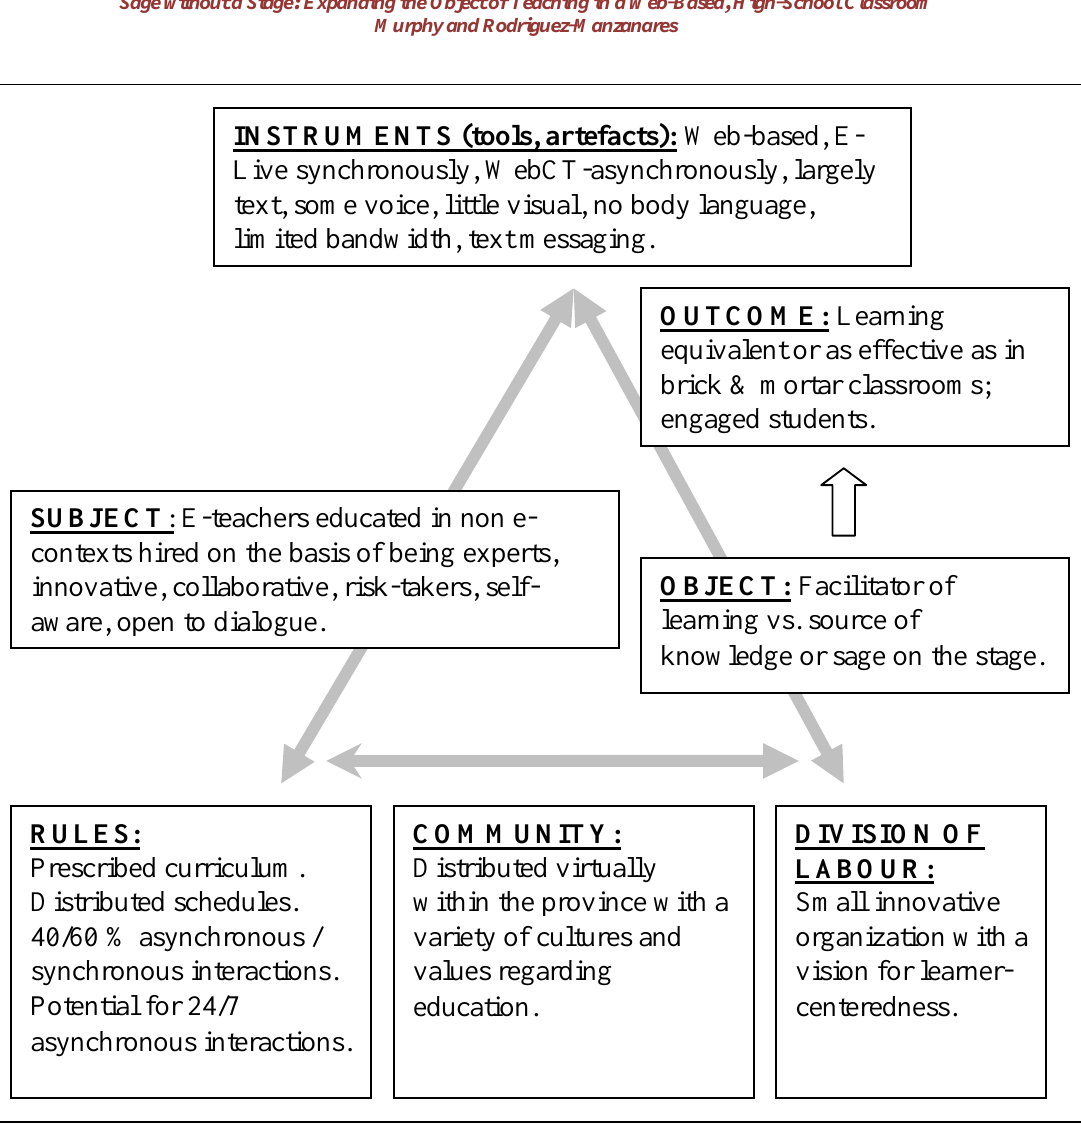
Figure 2. Activity system of e-teachers in